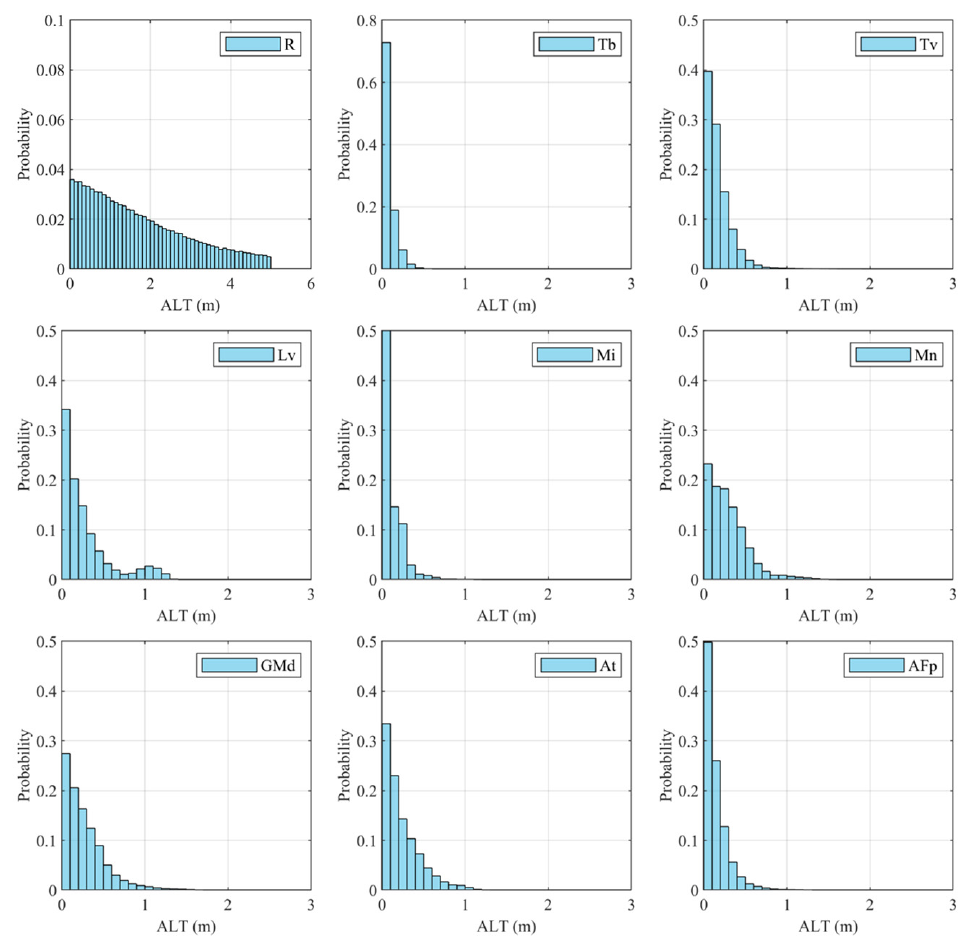
Figure 12. Statistic histograms of ALT in different sediments.